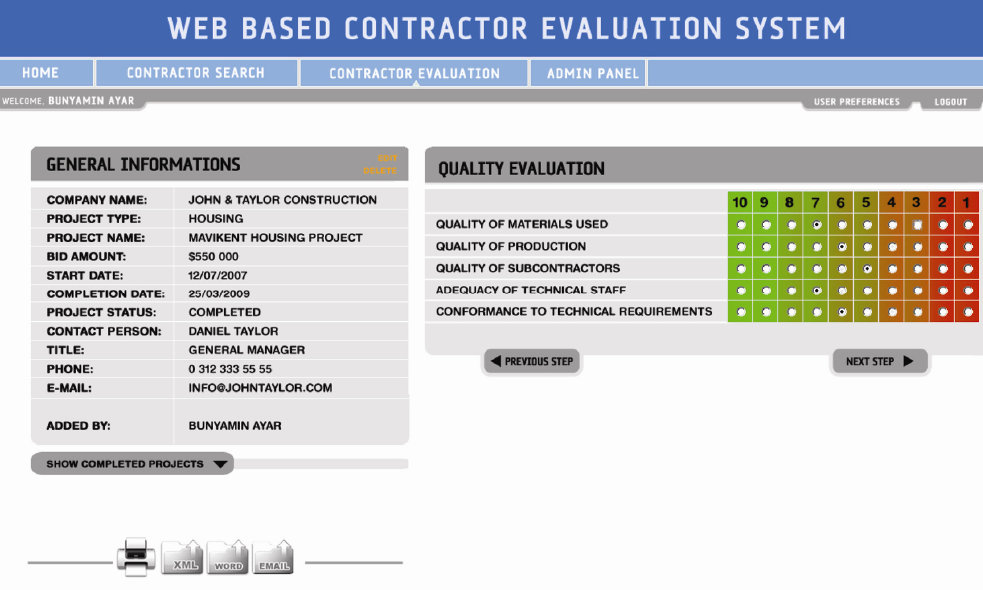
Fig. 6. Quality evaluation